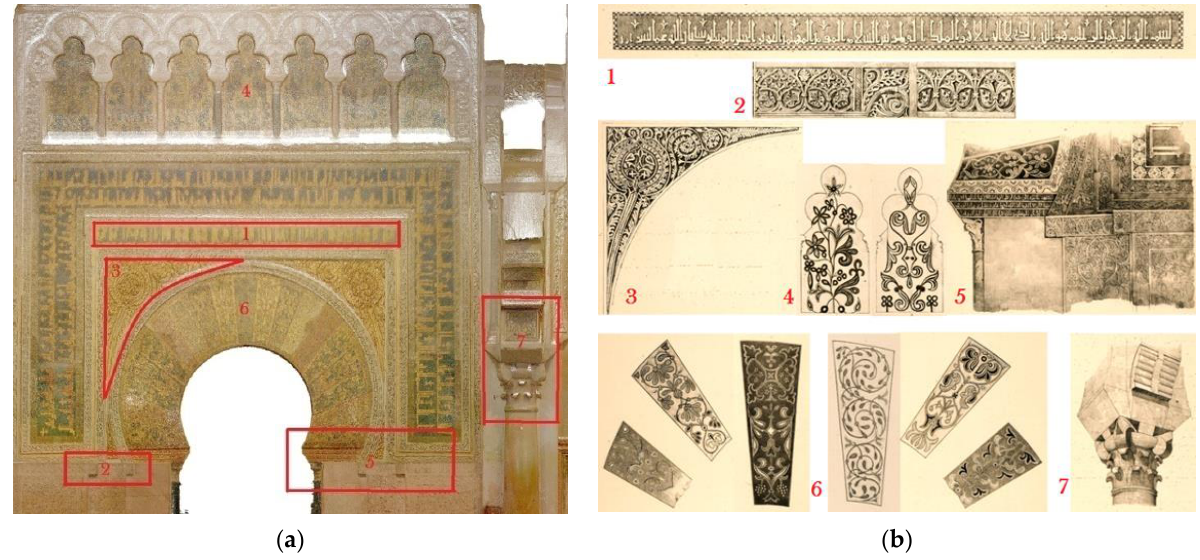
Figure 26. Details in the mihrab: ( a ) Point cloud from laser scanner; ( b ) Lithographs published by Girault de Prangey (1839). Source: Own production.